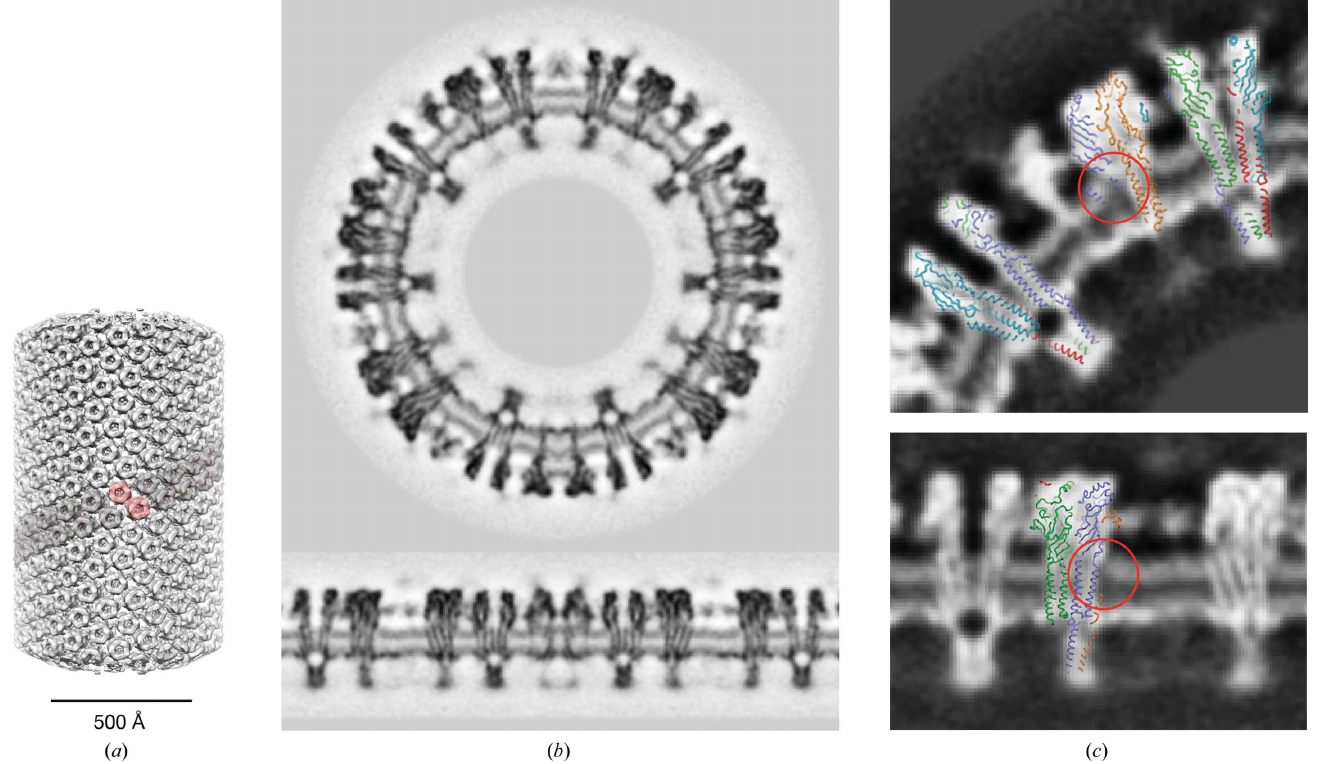
Figure 2 Single-particle helical reconstruction from ( (cid:3) 17, 5) tubes. ( a ) Masked-out volume showing the helical arrangement of ACh receptors; a (cid:2) – (cid:2) linked dimer of receptors and a ribbon of dimers are shaded in pink and grey, respectively. ( b ) Central cross-section (top) and radial section (bottom) from the three- dimensional density map cutting through receptors and the lipid-bilayer matrix in which they are embedded. ( c ) Enlargements of regions in ( b ) with atomic models of the ACh receptor (PDB entry 2bg9) superimposed. Circles identify areas next to the (cid:2) subunit where densities corresponding to the outer phospholipid headgroups are weak or missing; the adjacent helices are M1 (lower circle), and M4 and M1 (upper circle). Subunit colours: (cid:3) (cid:4) , red; (cid:3) (cid:2) , orange; (cid:5) , green; (cid:4) , cyan; (cid:2) , blue. Inverted Nigel Unwin (cid:4) Segregation of lipids near acetylcholine-receptor channels